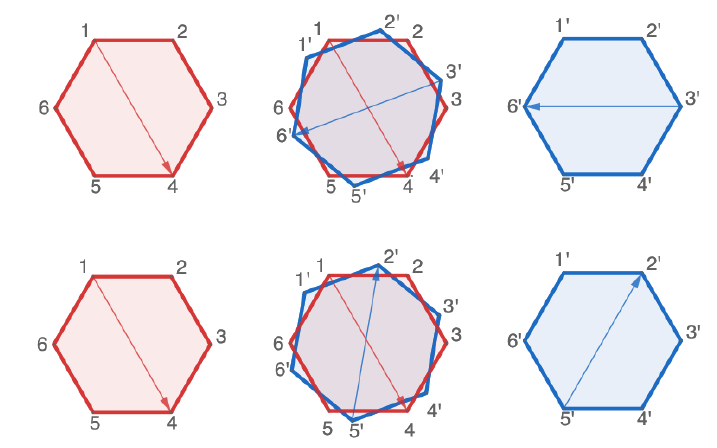
Figure 9 . The above (cid:12)gure shows 36 is Q -compatible with 14 but 25 is not. its Q-compatible diagonal, this corresponds to changing to a compatible channel for any 6-point diagram inside our (2 N + 2)-point diagram. This is the analogue of mutation for quartic case (see eq.